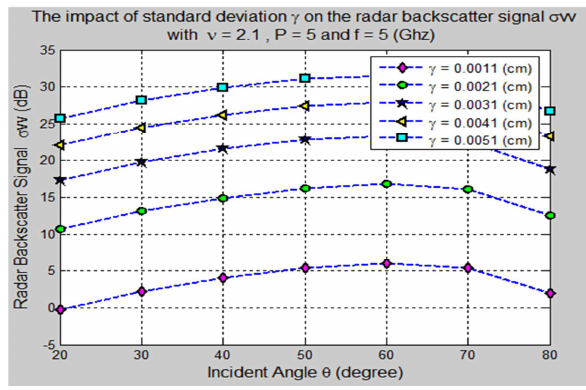
Figure 8. Backscattering coefficient dependence on standard